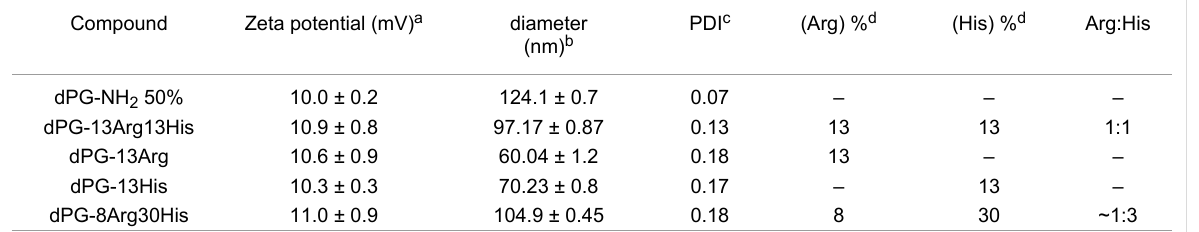
Table 1: Summary of AAdPG vectors and their corresponding polyplex characterization.